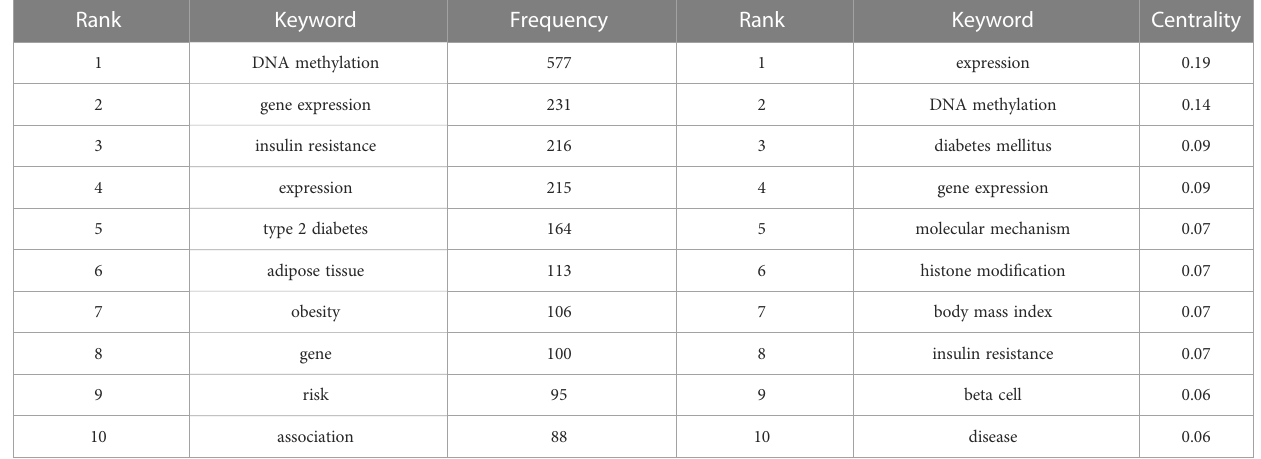
TABLE 4 Top 10 keywords of the publications related to T2DM and DNA/RNA methylation modi fi cations.